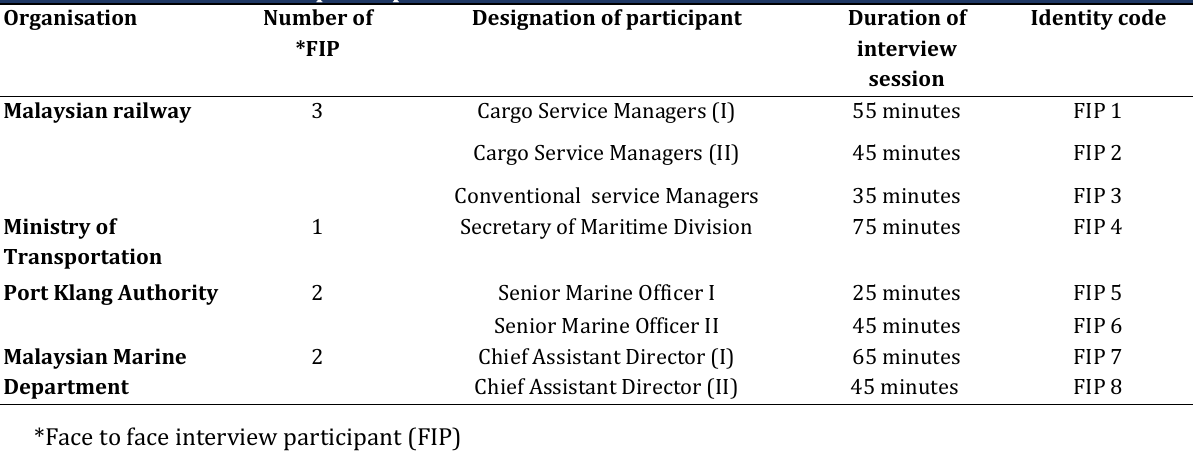
Table 2: Profile of interview participants and interview durations